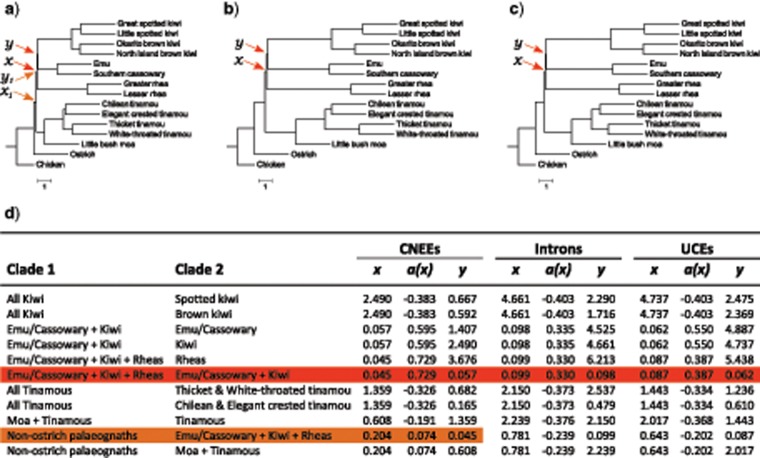
Pairs of short successive internal branches are consistent with expectations for the anomaly zone. Species tree topologies for CNEEs (a), introns (b), and UCEs (c) are shown with internal branch lengths in coalescent units estimated from best maximum-likelihood gene trees with MP-EST. Terminal branch lengths are uninformative and are drawn as a constant value across taxa. Coalescent branch lengths for all pairs of branches (\documentclass[12pt]{minimal}
\usepackage{amsmath}
\usepackage{wasysym}
\usepackage{amsfonts}
\usepackage{amssymb}
\usepackage{amsbsy}
\usepackage{upgreek}
\usepackage{mathrsfs}
\setlength{\oddsidemargin}{-69pt}
\begin{document}
}{}$CDATA[$CDATA[$x$$\end{document} and \documentclass[12pt]{minimal}
\usepackage{amsmath}
\usepackage{wasysym}
\usepackage{amsfonts}
\usepackage{amssymb}
\usepackage{amsbsy}
\usepackage{upgreek}
\usepackage{mathrsfs}
\setlength{\oddsidemargin}{-69pt}
\begin{document}
}{}$CDATA[$CDATA[$y)$$\end{document} are given in (d), with \documentclass[12pt]{minimal}
\usepackage{amsmath}
\usepackage{wasysym}
\usepackage{amsfonts}
\usepackage{amssymb}
\usepackage{amsbsy}
\usepackage{upgreek}
\usepackage{mathrsfs}
\setlength{\oddsidemargin}{-69pt}
\begin{document}
}{}$CDATA[$CDATA[$a(x)$$\end{document} calculated following Equation 4 from Degnan and Rosenberg (2006). Anomalous gene trees are expected when \documentclass[12pt]{minimal}
\usepackage{amsmath}
\usepackage{wasysym}
\usepackage{amsfonts}
\usepackage{amssymb}
\usepackage{amsbsy}
\usepackage{upgreek}
\usepackage{mathrsfs}
\setlength{\oddsidemargin}{-69pt}
\begin{document}
}{}$CDATA[$CDATA[$y$$\end{document}\documentclass[12pt]{minimal}
\usepackage{amsmath}
\usepackage{wasysym}
\usepackage{amsfonts}
\usepackage{amssymb}
\usepackage{amsbsy}
\usepackage{upgreek}
\usepackage{mathrsfs}
\setlength{\oddsidemargin}{-69pt}
\begin{document}
}{}$CDATA[$CDATA[$<$$\end{document}\documentclass[12pt]{minimal}
\usepackage{amsmath}
\usepackage{wasysym}
\usepackage{amsfonts}
\usepackage{amssymb}
\usepackage{amsbsy}
\usepackage{upgreek}
\usepackage{mathrsfs}
\setlength{\oddsidemargin}{-69pt}
\begin{document}
}{}$CDATA[$CDATA[$a(x)$$\end{document}. Clades fulfilling this anomaly zone criterion are shaded in (d), with the corresponding branches indicated in a–c.